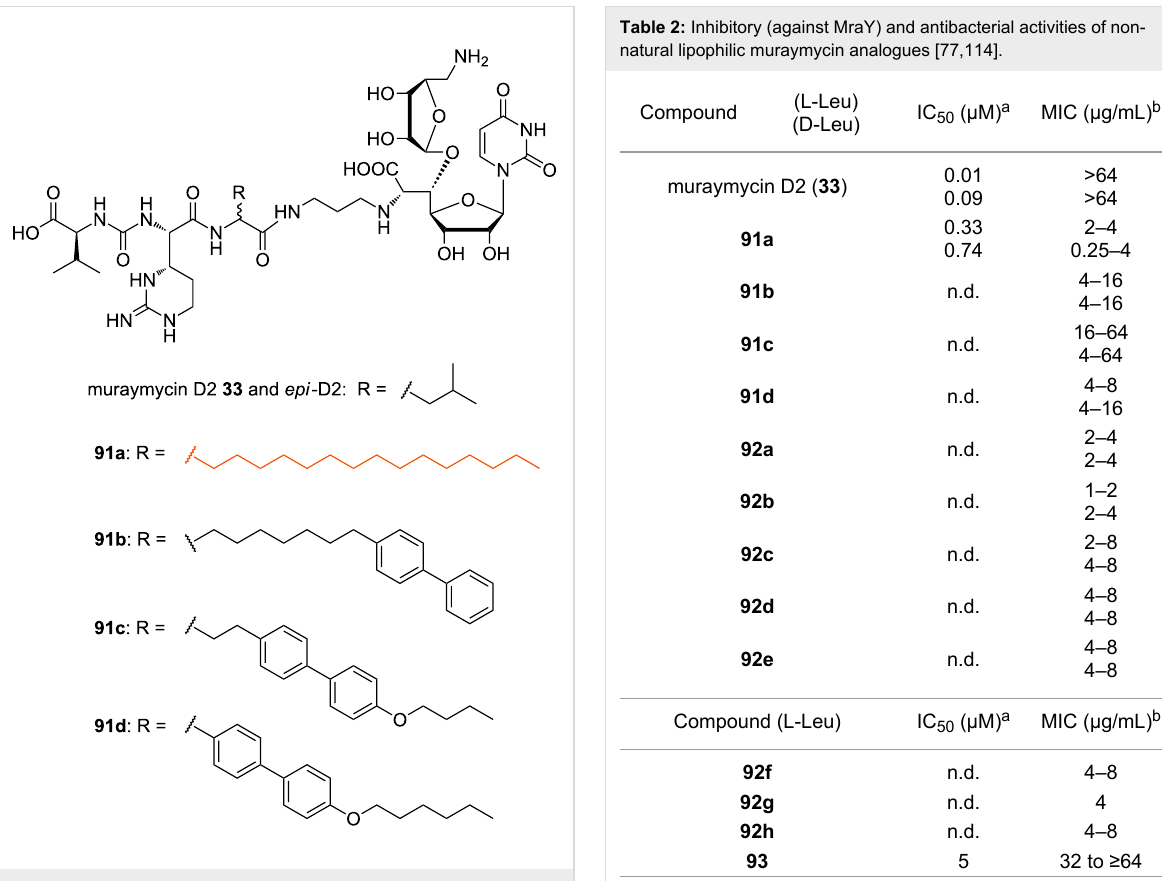
Figure 9: Muraymycin D2 and several non-natural lipidated analogues 91a – d [77,114].